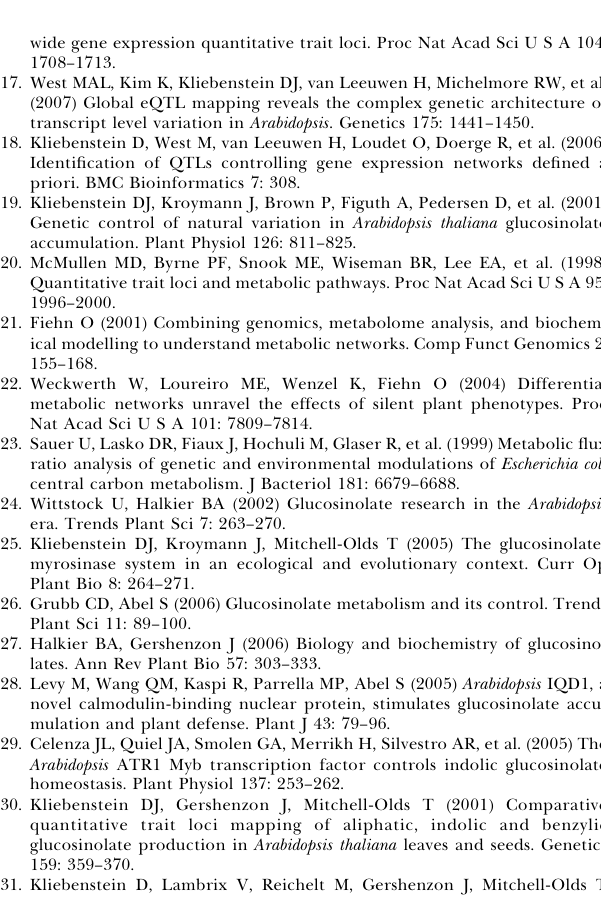
Table S6. eQTL for Glucosinolate Biosynthetic Genes Significant eQTLs previously detected for each glucosinolate bio- synthetic gene. The genetic position in chromosome and cM is presented along with the genes’ identities. In addition, the additive effect of the Bay-0 allele at each eQTL is provided. Found at doi:10.1371/journal.pgen.0030162.st006 (31 KB XLS). Table S7. Average Gene Network Expression ( z -Score) The mean z -score for each RIL for the aliphatic glucosinolate and indolic glucosinolate biosynthetic pathways are presented for the 211 RILs where there are available data. Table S8. Metabolic QTLs for Indolic Glucosinolate Traits QTLs detected for each indolic glucosinolate trait are presented as a separate table. The average trait value per RIL across experiments along with the trait value per RIL for each individual experiment was used for QTL mapping, and the presence of a QTL in a specific experiment is shown under ‘‘ QTL Detection in Given Experiment. ’’ The MT QTL column shows the complete results from the multitrait composite interval mapping within QTL Cartographer. M means that the QTL was identified as a main effect, while I means that it had an experiment specific interaction, and MI shows that it was found with both main and interaction effects using multitrait composite